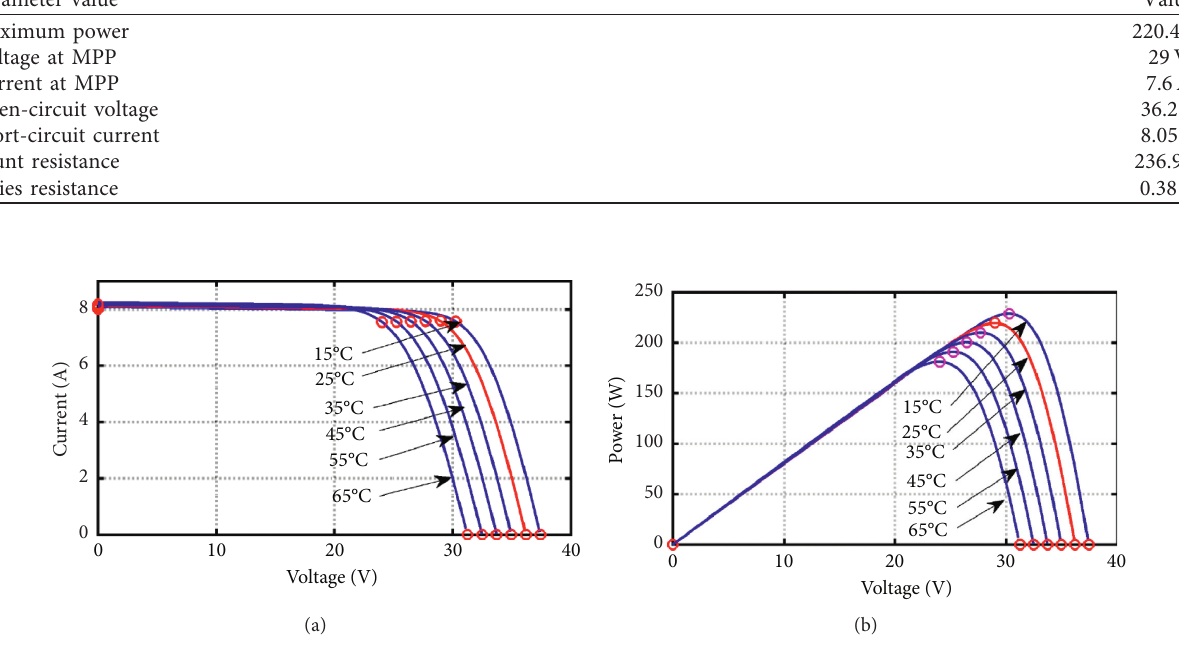
Figure 6: Characteristics of used PV panel at 1000W/m 2 for different temperatures. (a) I–V curves. (b) P–V curves.